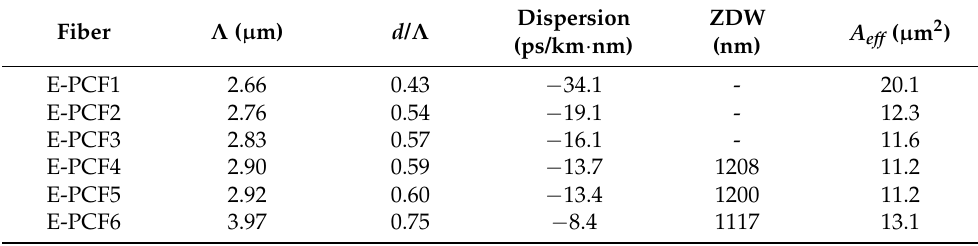
Figure 6. ( a ) SEM images of ethanol-filled PCFs cross-section. ( b ) Chromatic dispersion of PCFs with holes filled ethanol. Dashed vertical black line indicates the experimental pump wavelength. Table 2. Structural parameters, dispersion and effective mode area at 1064 nm of ethanol-filled